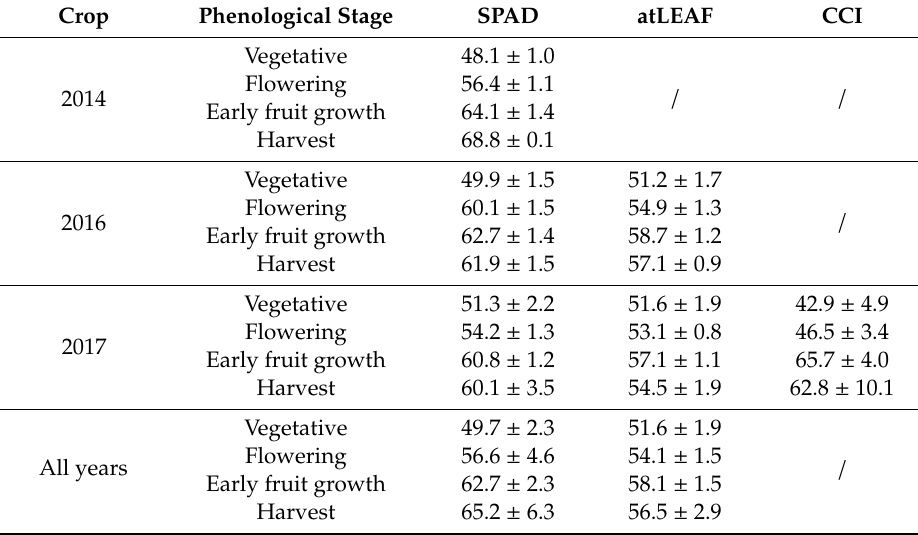
Table 9. Su ffi ciency values of SPAD, atLEAF, and CCI, in each of the four phenological stages, for individual sweet pepper ( Capsicum annuum ) crops and for all years combined. Values are means ± standard error